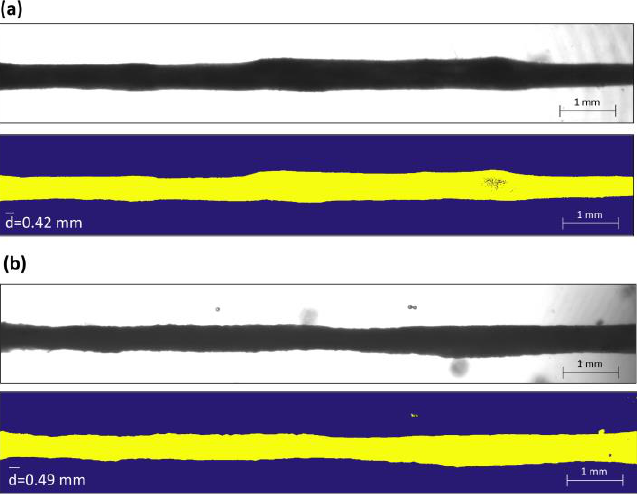
Figure 5. Example of two X-METs acquired for the calculation of the CSA. All the images were acquired at 1X magnification and a resolution of 2040 × 300 pixels. Top, image of the X-MET acquired with the camera; bottom, the same image after being processed with the Matlab program for the calculation of the average diameter, respectively for a control ( a ) and a treated ( b ) sample.